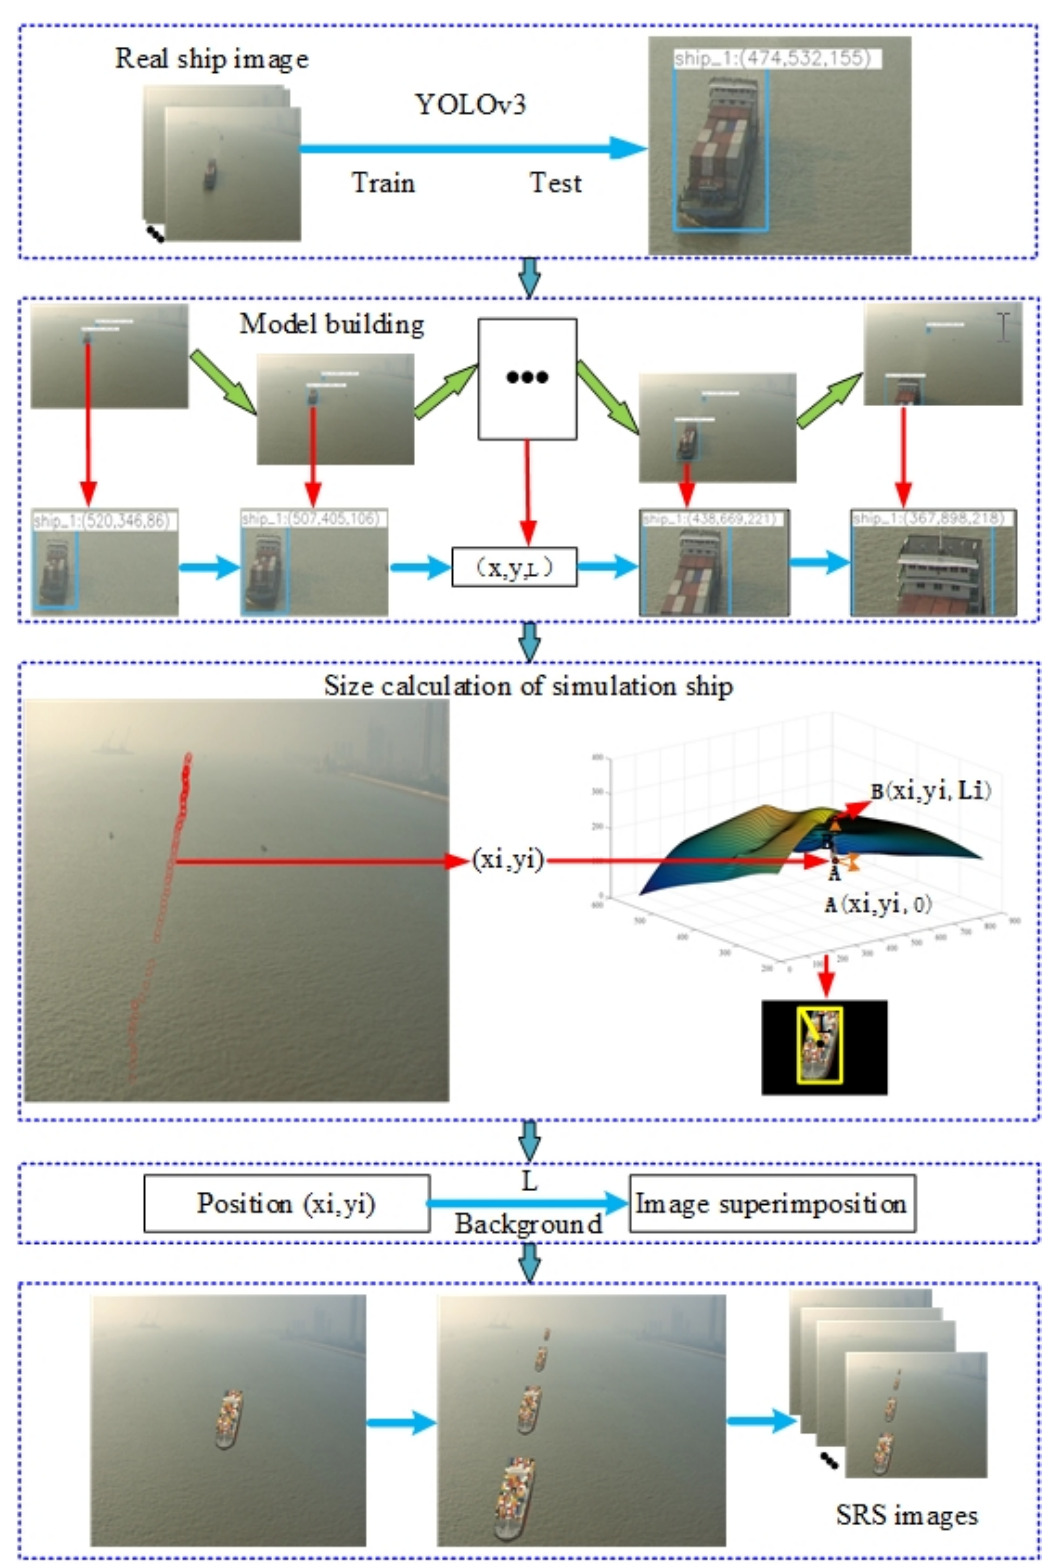
Figure 7. Flow chart of SRS images generation method.